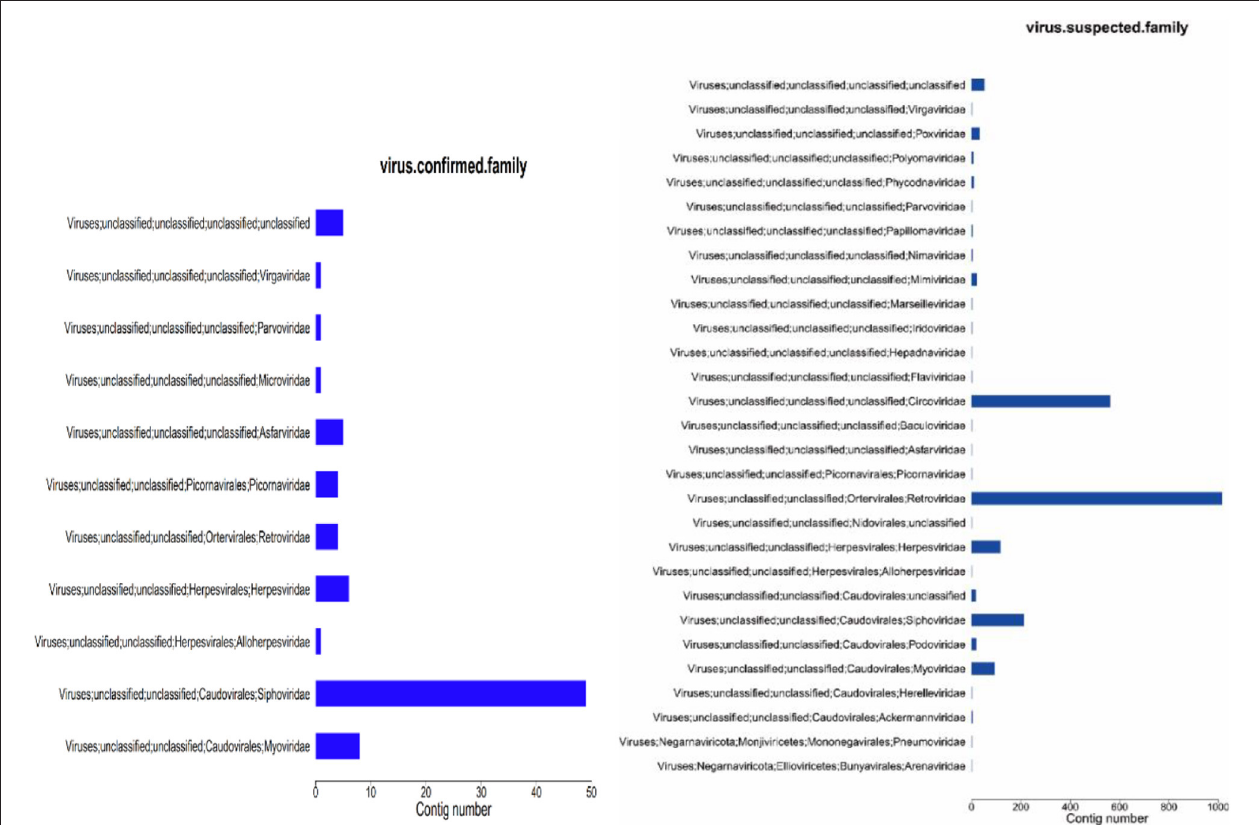
FIGURE 5 | Virus annotation statistics (family level). (1) abscissa: number of contigs; ordinate: comment information.